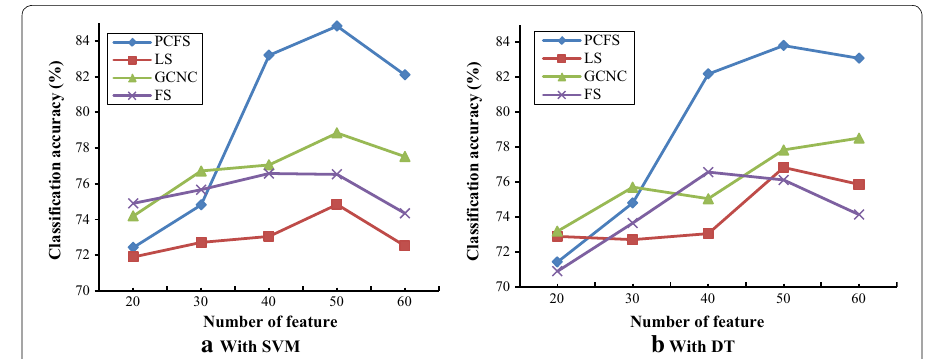
Fig. 5 Classification accuracy (average over 10 runs), on Colon dataset with respect to the number of selected features with a SVM classifier, and b DT classifier